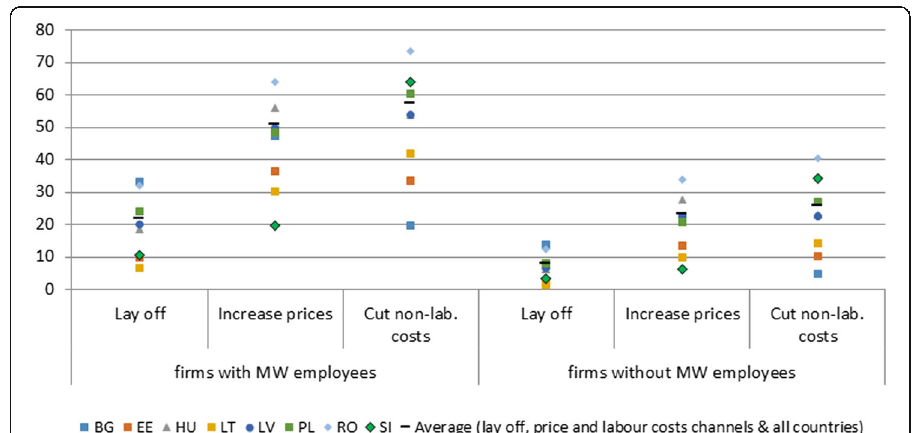
Fig. 2 Predicted probabilities of the adjustment channels being ‘ Relevant ’ by country (all countries, a subset of channels). Note: For Slovenia, the effect for firms without MW employees is rather hypothetical, assuming that Slovenian firms (with their characteristics taken into account) would react as firms without MW employees in other countries without actually having the actual responses of Slovenian firms without MW employees included in the sample. Authors ’ calculations using the multivariate probit model presented